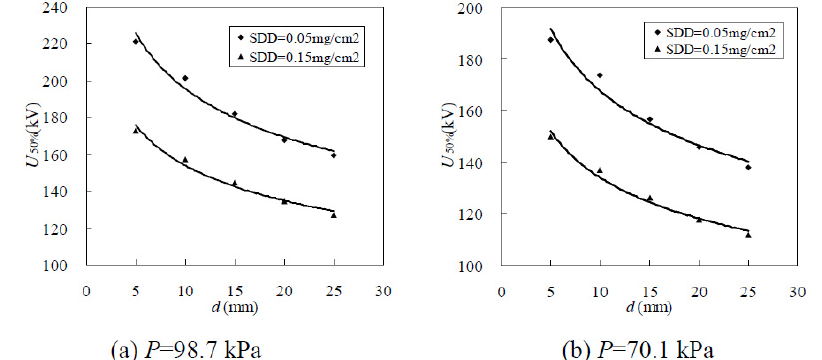
and d of XZP-210 insulator string covered with ice ( N = Figure 5. The relationship of U 50%